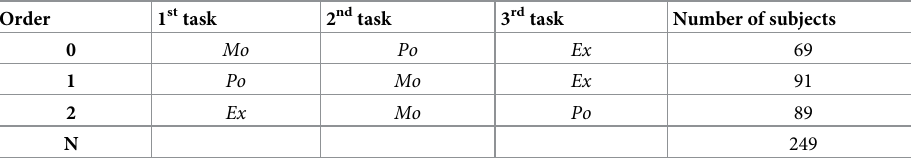
Table 5. Order of treatments.